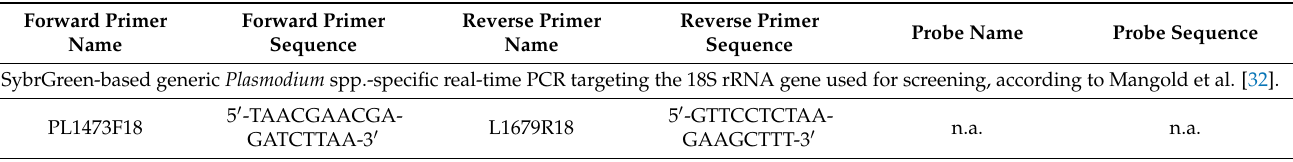
Table 1. Oligonucleotide sequences of the applied non-commercial malaria real-time